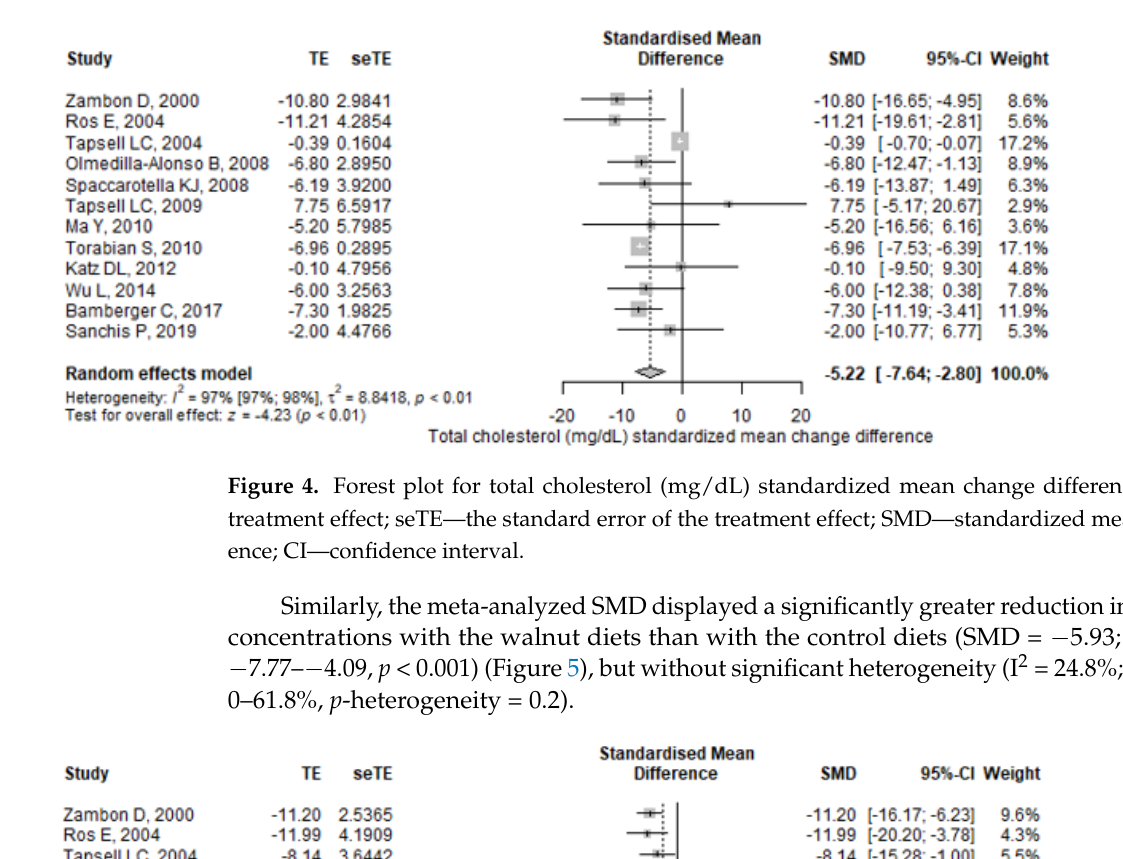
11 of 21 Figure 3. Forest plot for triglycerides (mg/dL) standardized mean change difference compared with subgroup analyses for risk of bias. TE — treatment effect; seTE — the standard error of the treatment effect; SMD — standardized mean difference; CI — confidence interval. 3.1.2. Total Cholesterol, LDL, and HDL Cholesterol